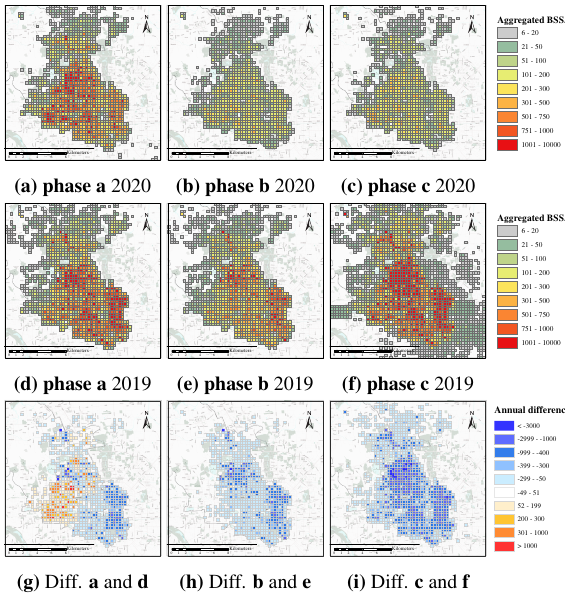
Figure 3. Comparison of shared-bike usage between 2019 and 2020 in different